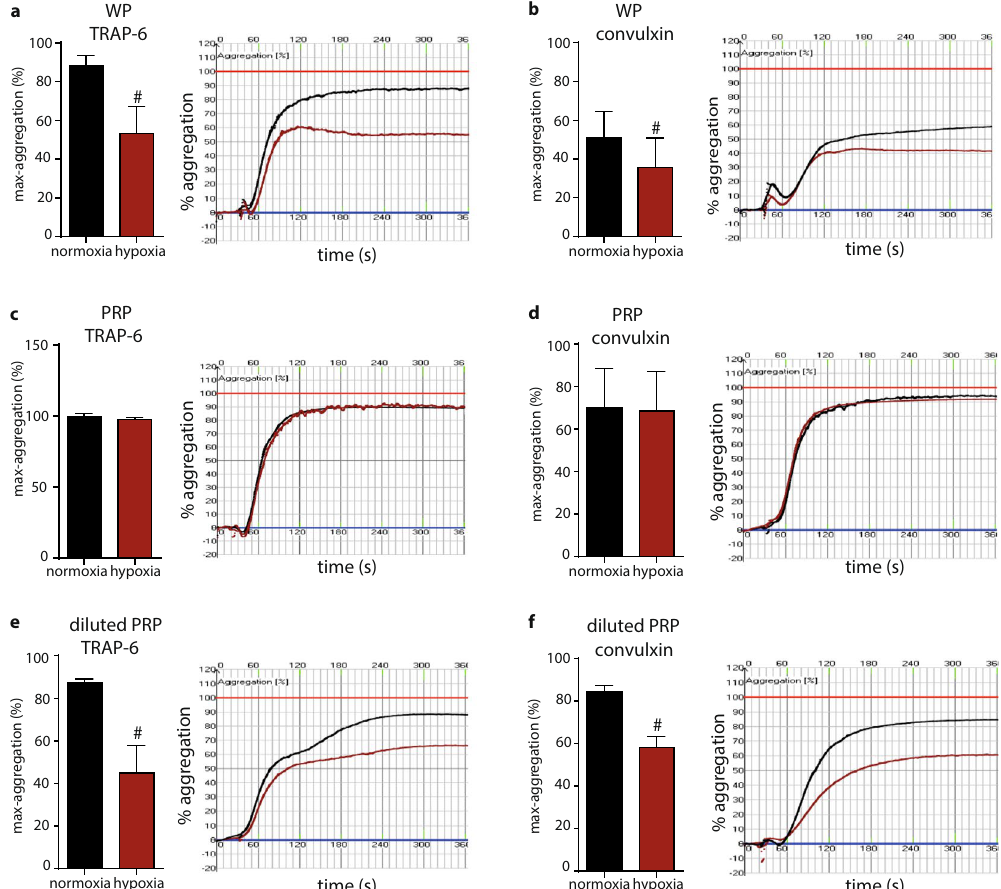
Figure 1. Hypoxia-induced inhibition of platelet aggregation. % of aggregation and representative aggregation curves of stimulated washed platelets (WP) with ( a ) 10 µ M TRAP-6 (n = 5, p = 0.028) and ( b ) 10 ng/ml convulxin (n = 6, p = 0.041), platelet-rich plasma (PRP) stimulated with ( c ) 0.5 µ M TRAP-6 (n = 4) and ( d ) 1–5 ng/ml convulxin (n = 5) and buffer- diluted PRP stimulated with ( e ) 4 µ M TRAP-6 (n = 6, p = 0.025) and ( f ) 2.5 ng/ml convulxin (n = 5, p = 0.0149) after incubation in normoxia or hypoxia (1% oxygen) for 30 min. Platelets incubated in normal oxygen levels are shown in black. Platelets incubated in hypoxia are shown in red. All data were expressed as the means ± SEM. Statistical comparisons were performed using the paired Student’s t -test, # p < 0.05, data from graphs ( a ), ( b ), ( d ), ( e ) and ( f ) are normally distributed according to Kolmogorov- Smirnov normality